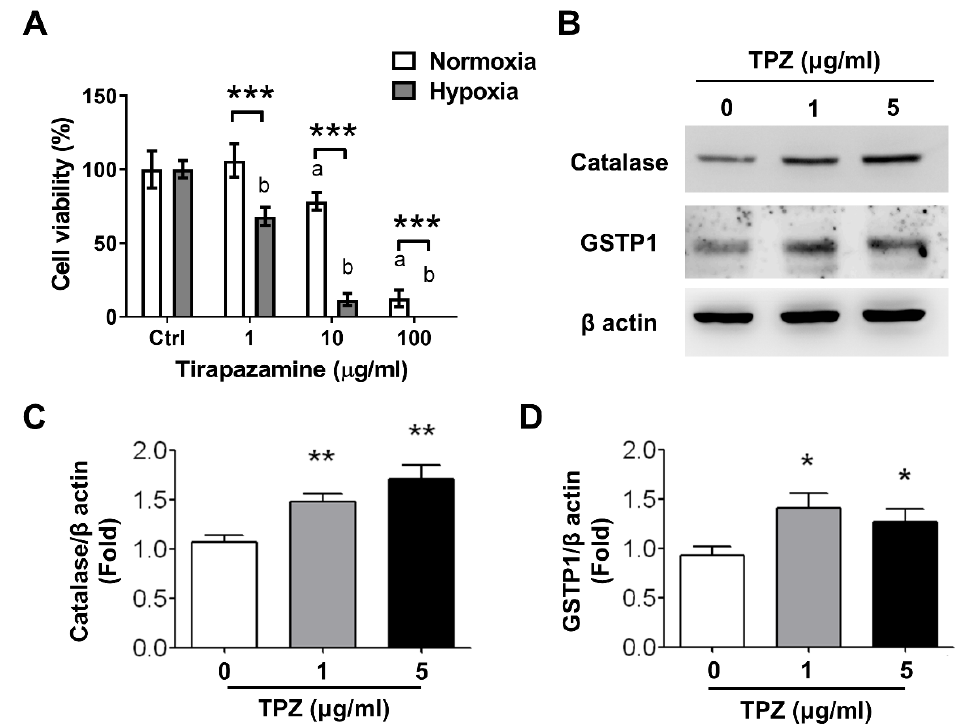
Figure 5. Effect of Tirapazamine (TPZ) on cell viability of gastric cancer MKN45 cells. The viability of MKN45 cells exposed to PBS only (indicated in Ctr) or TPZ at 1, 10, or 100 μ g/mL for 48 h was measured by using WST-1 assay ( A ). The lowercase letter “a” indicates statistical significance compared to control under normoxia, and the “b” indicates statistical significance compared to control under hypoxia; *** p < 0.001 represents statistical significance between the labeled groups. TPZ aggravated the reduction in cell viability of MKN45 gastric cancer cells incubated under hypoxia ( B ). TPZ increased the expression of oxidative-stress-leaded enzymes, such as catalase and GSTP1 ( C , D ); ** p < 0.01 and * p < 0.05 represent statistical significance between the labeled groups.